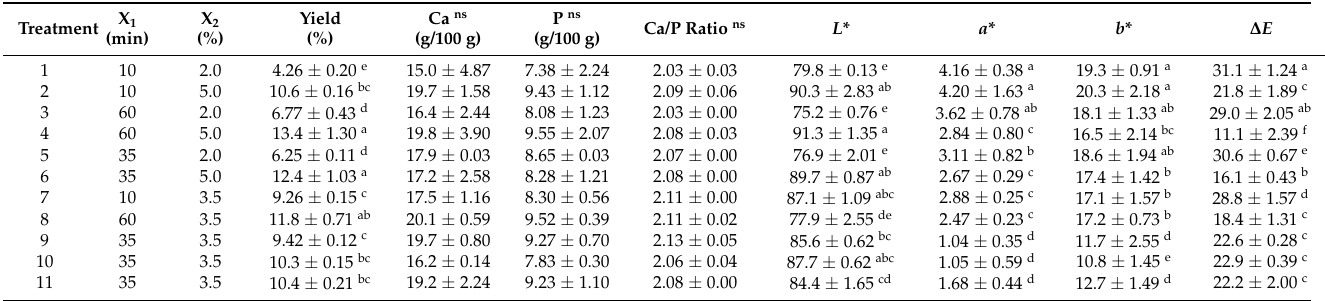
Table 1. Experimental unit and response variables for hydroxyapatite extraction from bigeye snapper bones.